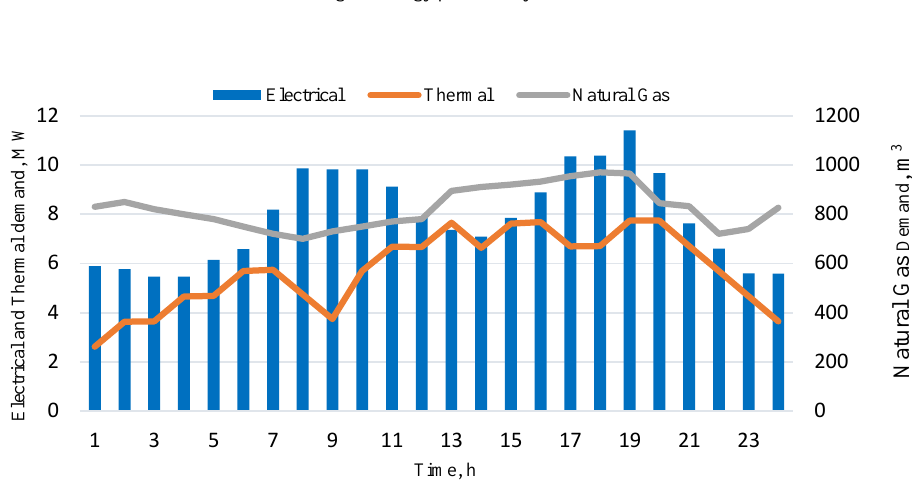
Fig. 6. Energy demand in